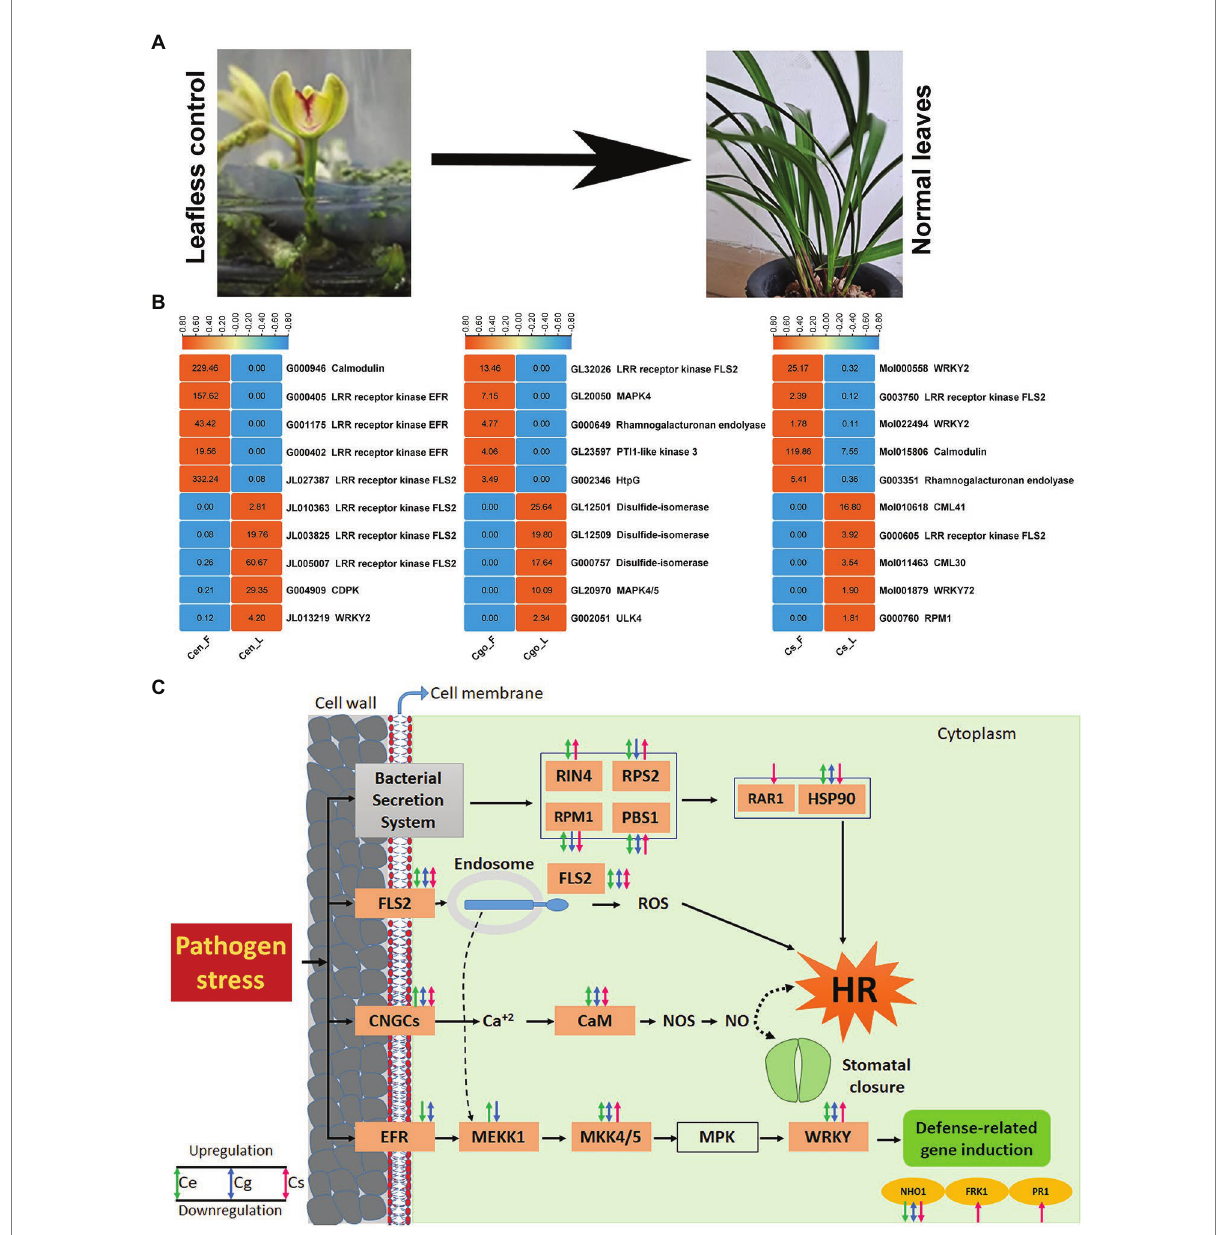
FIGURE 7 Leaf-less control and the healthy leaf samples used for sequencing analysis (A) , top 5 highly upregulated and highly downregulated defense- related DEGs (B) , and the final pathway of pathogen stress showed by three orchid species (C) . The orange boxes show the genes expressed in either of the